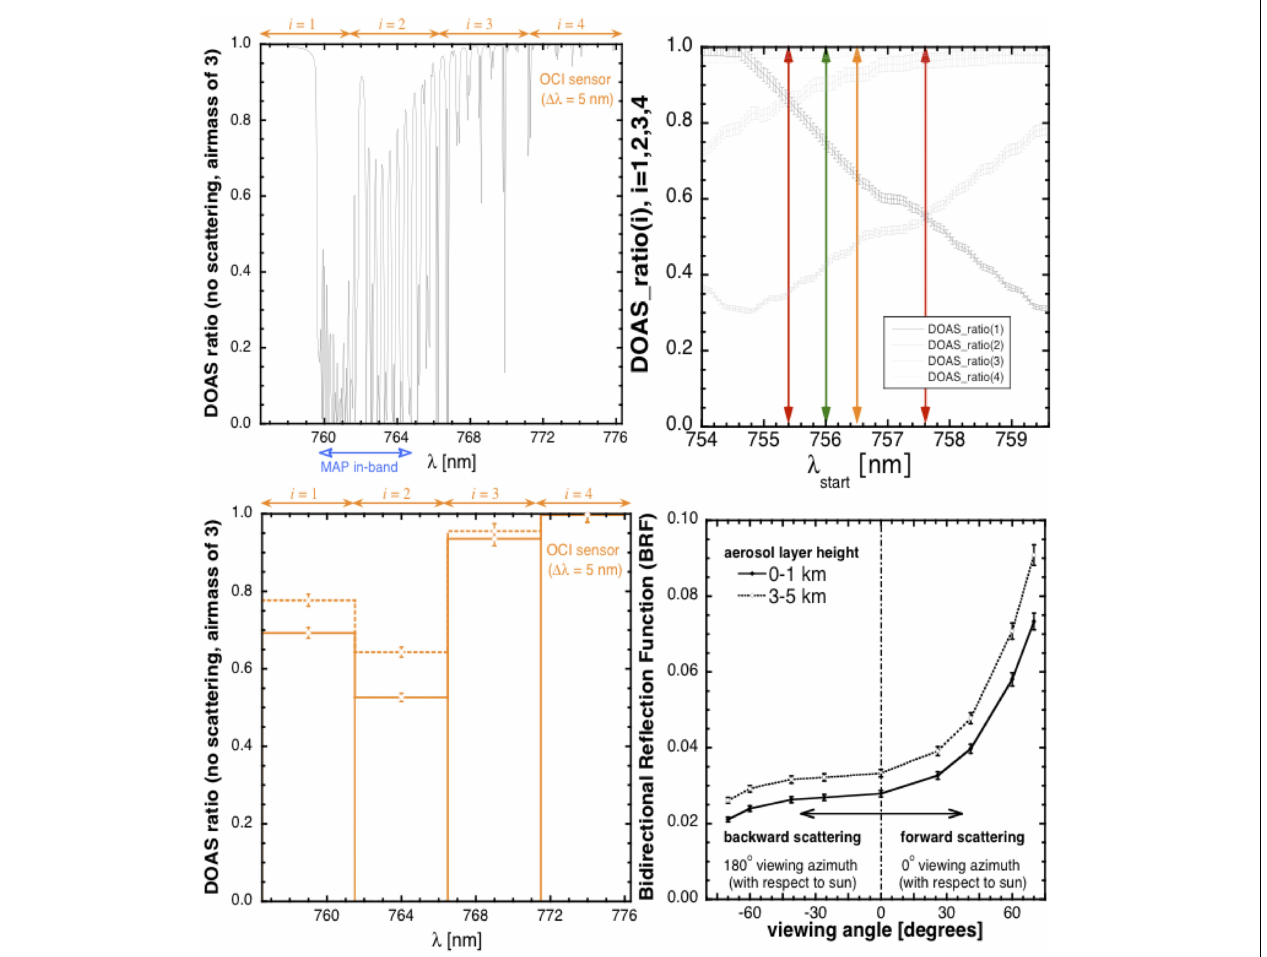
FIGURE 4 | (Upper left) Synthetic spectrum of the O 2 A-band at 0.05 nm resolution, normalized in DOAS-style to continuum level, for a typical airmass of 3 (e.g., sun at 60 ◦ , nadir view). An anticipated spectral coverage by the OCI hyperspectral sensor (4 channels, each 5 nm wide) is indicated above in orange, and a reasonable assumption for the single MAP channel is indicated below in blue. (Upper right) Evolution of DOAS ratios with 2% error for an airmass of 3 for the 4 hyperspectral OCI channels needed to completely cover the A-band as a function of where the 1st one starts. One good, two bad, and one average scenarios in terms of ratio separations are color-coded in green, red and orange, and the latter values are used in the lower left-hand panel. (Lower left) Reflected DOAS ratios for optically thin [AOD(O2A) = 0.1] boundary layer and lofted aerosol layer in the 0–2 km (solid) and 3–5 km (dashed) zones, respectively, assuming the sun is 60 ◦ from zenith and nadir viewing geometry. (Lower right) Bidirectional reflection function (BRF) for the MAP signal as a function of view angle. Even at typical radiometric noise levels, assumed to be 3%, the two aerosol layer elevations are easier to distinguish here than in lower-left, using instrument error magnitude as unit of signal distance. Reprinted by permission from Springer Nature: Davis and Kalashnikova